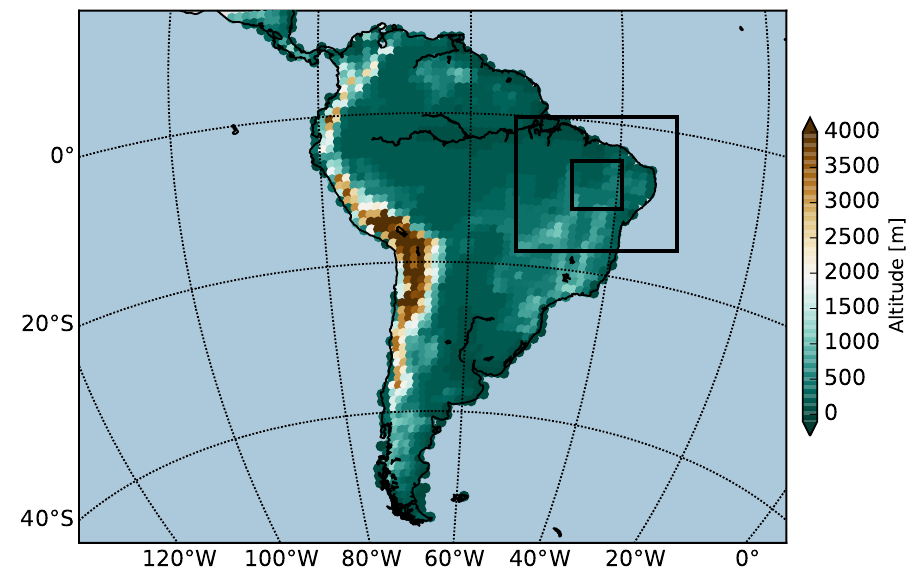
Figure 1. Schematic view of our nesting steps. The larger enclosed area corresponds to a 0.1 ◦ resolution and the smaller one to a 0.02 ◦ resolution of CCLM in the respective regions (in rotated coordinates as described in the